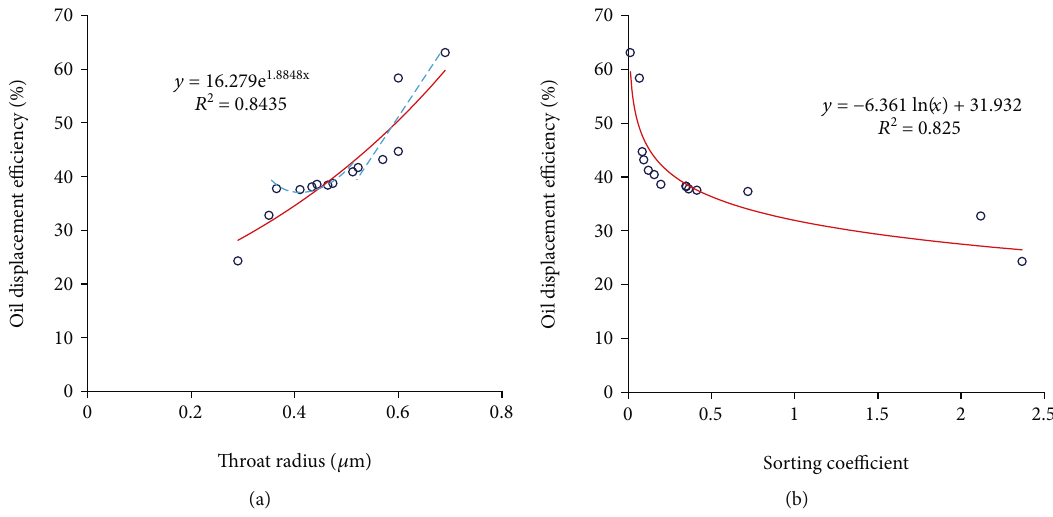
y = 16.279e 1.8848x R 2 = 0.8435